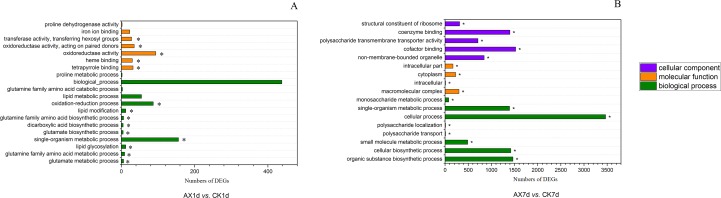
GO enrichment analysis of DEGs in all comparison groups.The top twenty most enriched GO terms in the comparison groups (A) AX1d vs. CK1d (B) and AX7d vs. CK7d. Asterisks (*) indicate significantly (Q-value < 0.05) enriched GO terms.